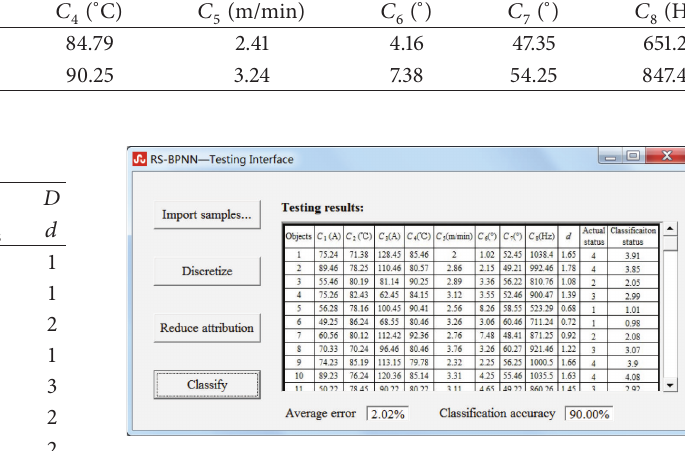
Figure 8: The testing interface of RS-BPNN